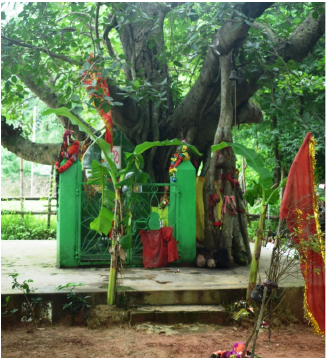
Figure 2. Banyan tree with village